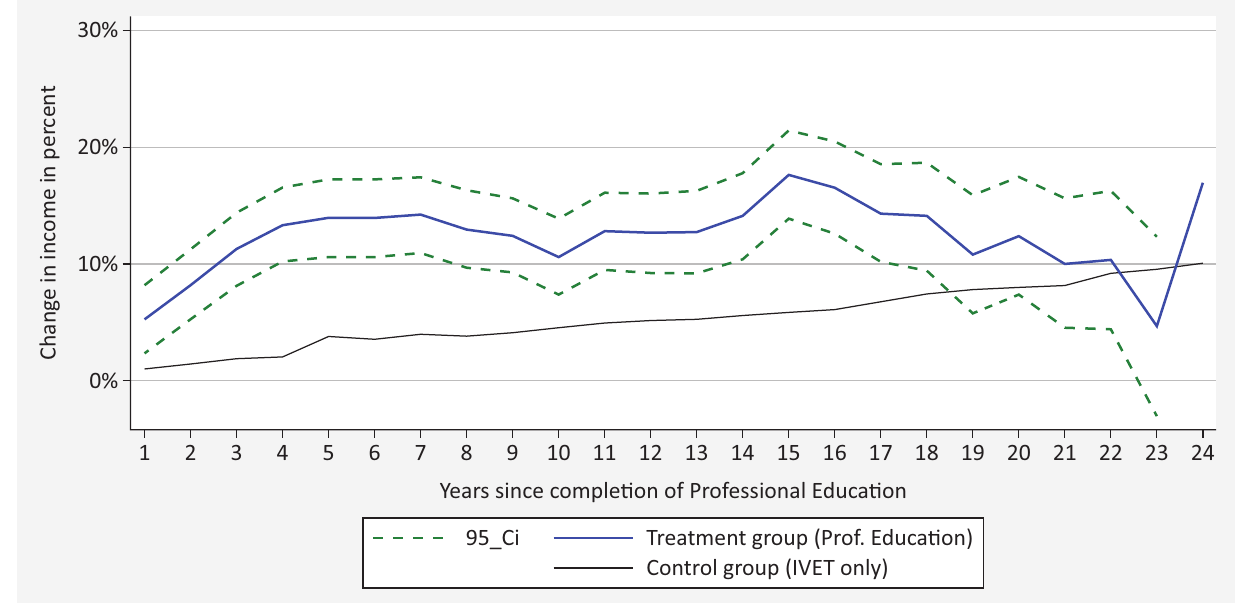
Figure 1. Income change due to professional education (impact